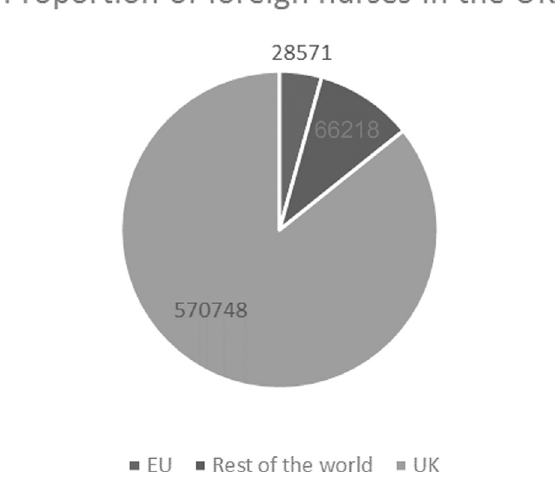
Figure 2. Proportion of foreign nurses in the UK. Source: Nursing and Midwifery Council – Title: Migrant salary rules may cost the NHS nurse jobs, the union warns